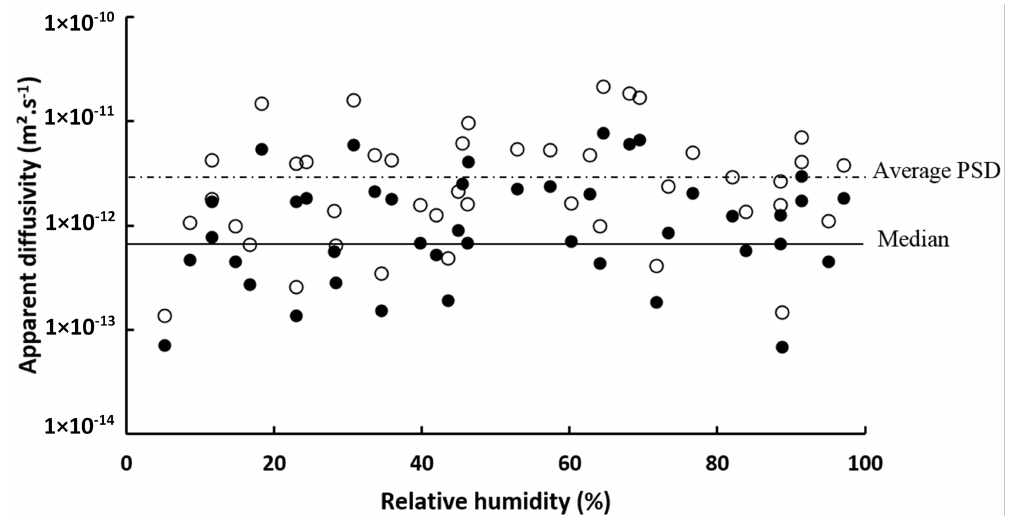
Figure 6. Water vapor apparent diffusivity in cellulose particles at different relative humidities, obtained by using median diameter and length ( ) or the particle size distribution (PSD) with median values for each classes (o). Lines represent mean values of apparent diffusivity.